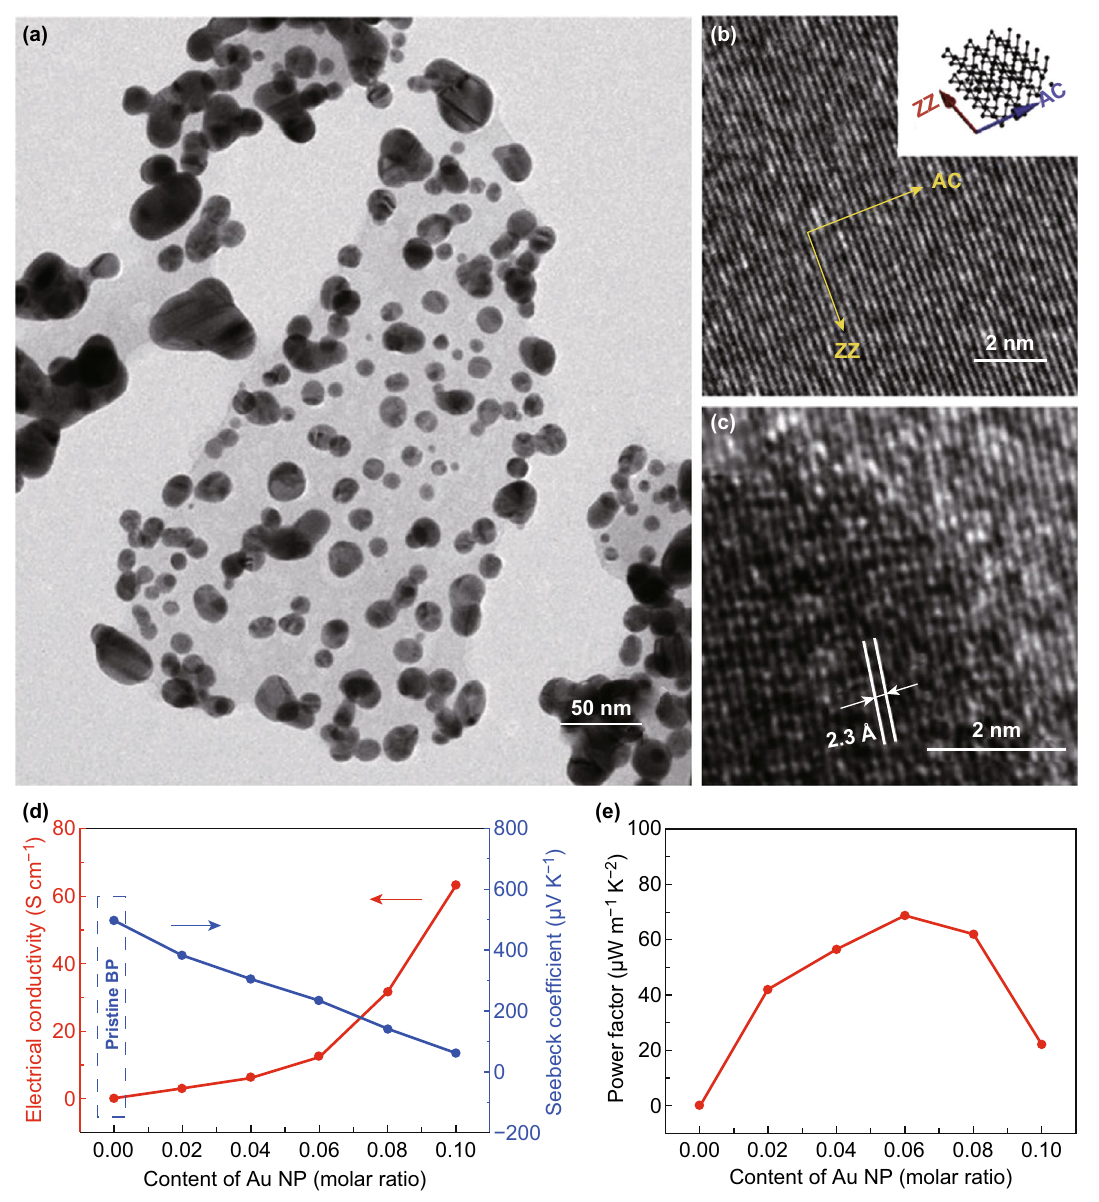
Fig. 6 a Low-magnitude TEM image of the black phosphorus nanosheet decorated with Au nanoparticles. b Lattice image of the exfoliated black phosphorus nanosheet (inset illustration showing the corresponding crystal structure). c High magnitude HRTEM image of the black phos- phorus nanosheet decorated with Au nanoparticles. d In-plane Seebeck coefficient, electrical conductivity, and e their corresponding in-plane power factor of the black phosphorus decorated with Au nanoparticles. Reproduced with permission from Ref. [129]. Copyright 2018, Wiley–